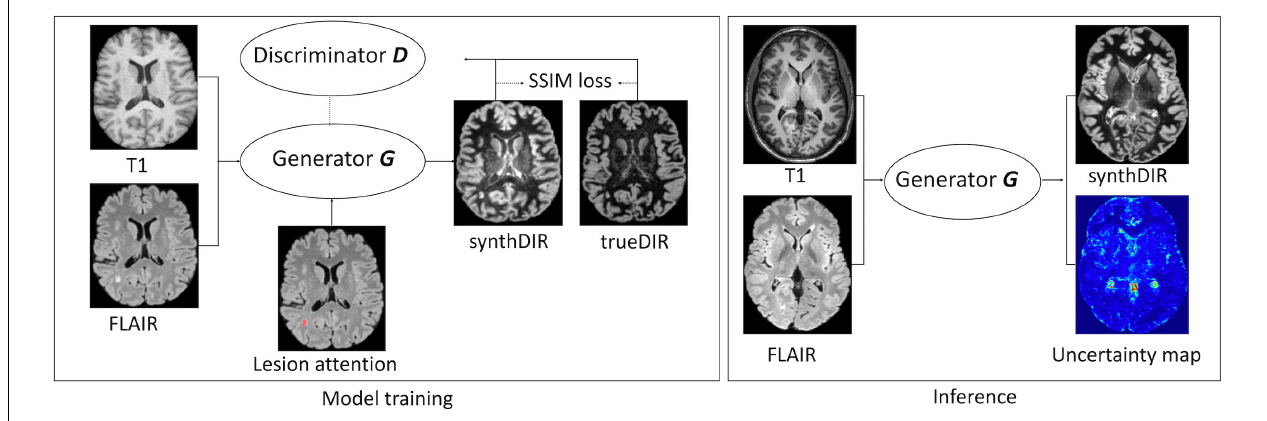
FIGURE 1 | Architecture, training process, and inference of the image synthesis task. The image Generator G uses the combination of FLAIR and T1w as input to generate synthDIR. The additional supervision from the lesion maps in the training stage drives an enhanced translation of MS-specific lesions (lesion attention). The feedback on the similarity between synthDIR and trueDIR is given by the Discriminator D and a structure similarity loss function and it updates the network weights until the loss function to discern both image pairs is minimal. During the inference stage, the trained generator G can generate the synthDIR and an uncertainty map showing the confidence of the output relating to each voxel. Uncertainty maps are calculated from the voxel-wise variances in signal intensities, as explained in the section “Materials and